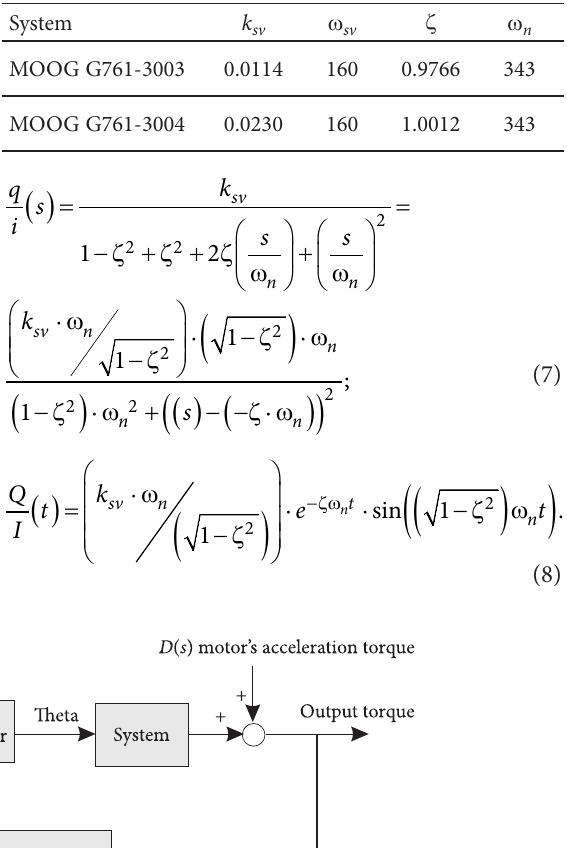
Table 1. Specifications of the system (Li, Thurner 2013)